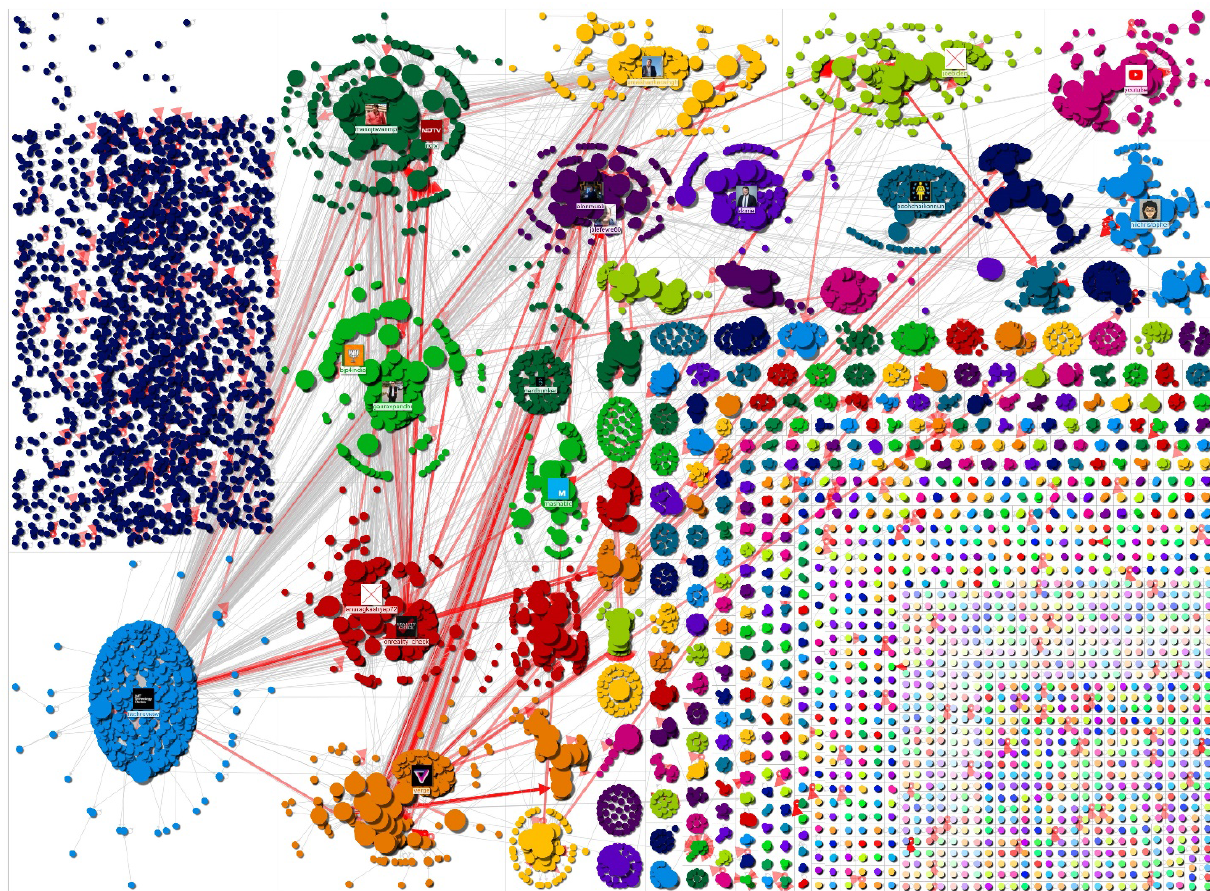
Figure 2. Illustration of the 20 actors most-referenced by